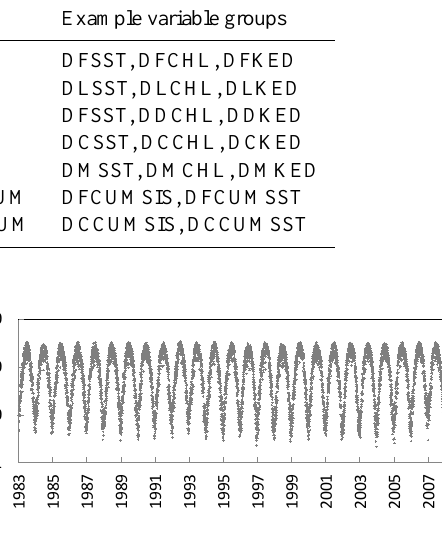
Figure 2. Time series of the daily surface incoming shortwave irra- diance (SIS,Wm − 2 ) derived from geostationary Meteosat sensors, averaged over the shaded area of the Baltic Sea shown in Fig.